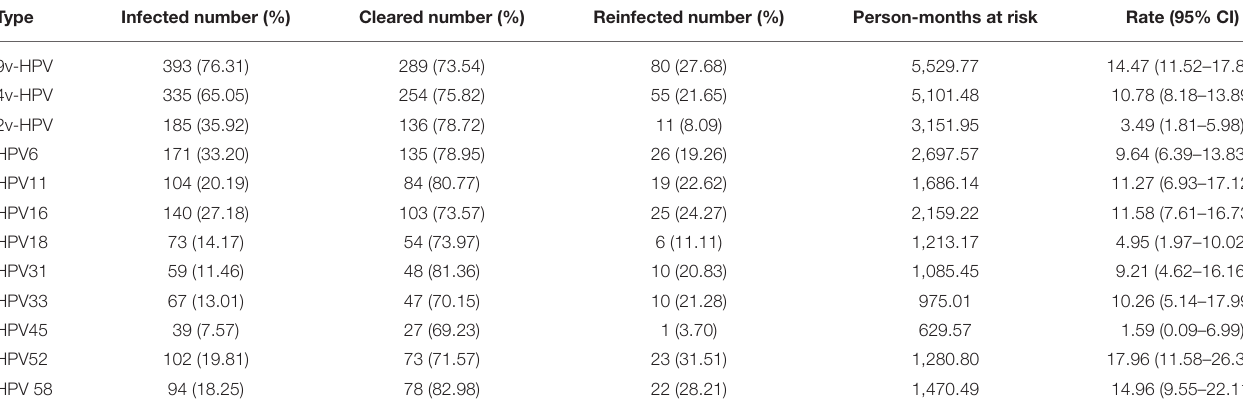
TABLE 2 | Incidence rates * of reinfection of human papillomavirus (HPV) among HIV-negative MSM ( N = 515).